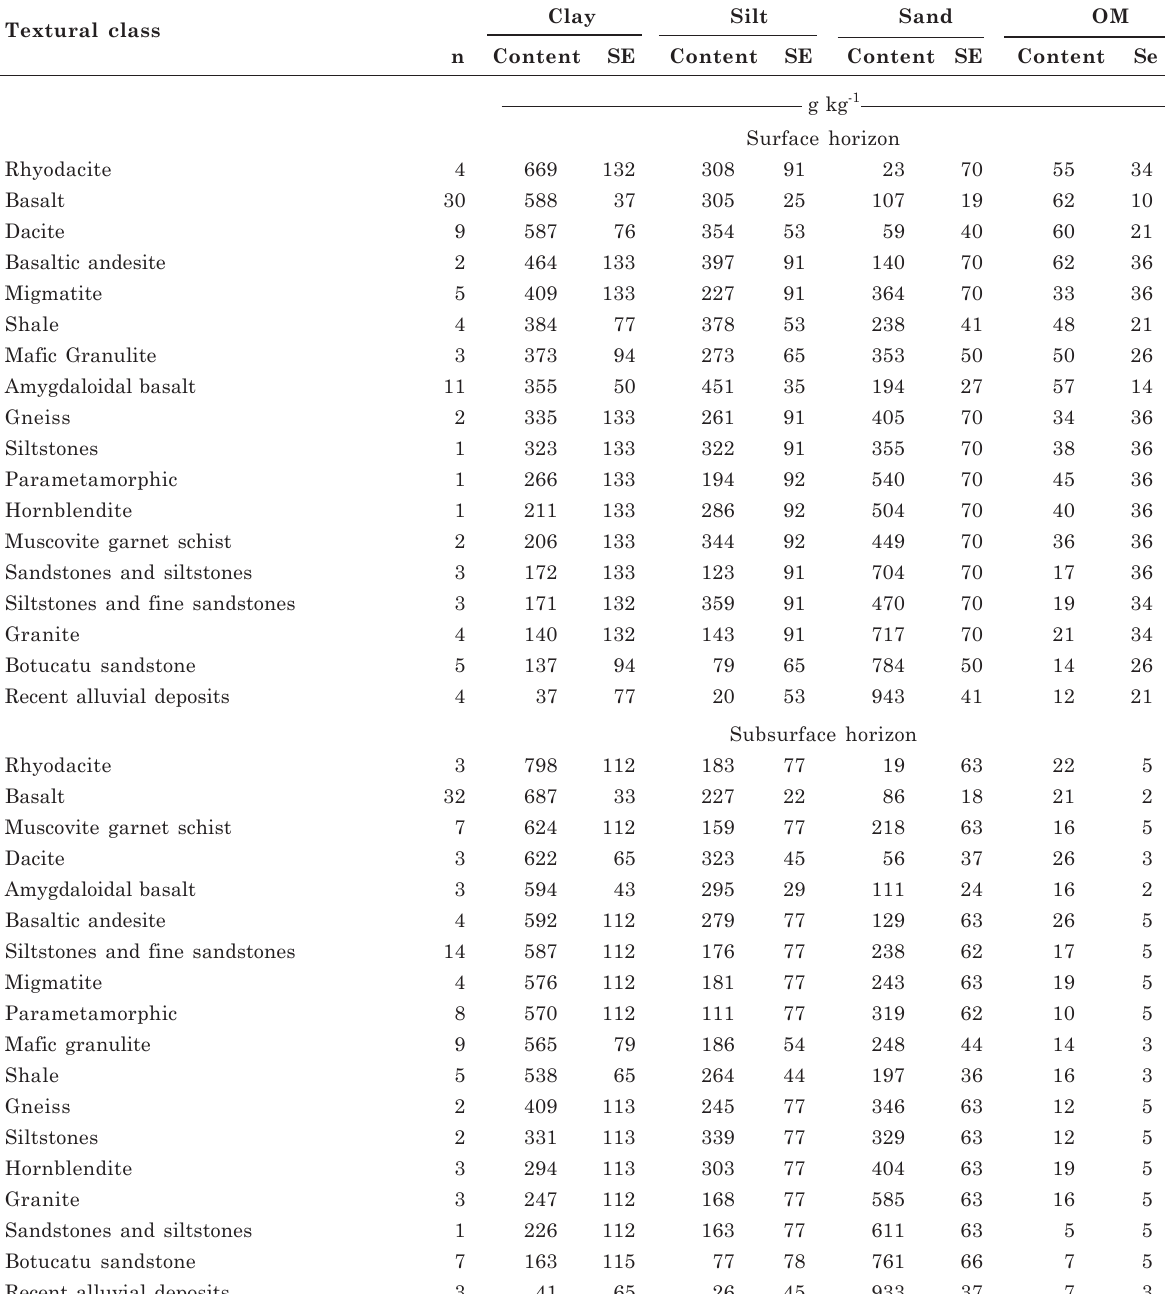
Table 6. Number of horizons (n), mean contents and standard error (SE) of the estimate for clay, silt, sand and organic matter (OM) in soils grouped by lithology in the State of Santa